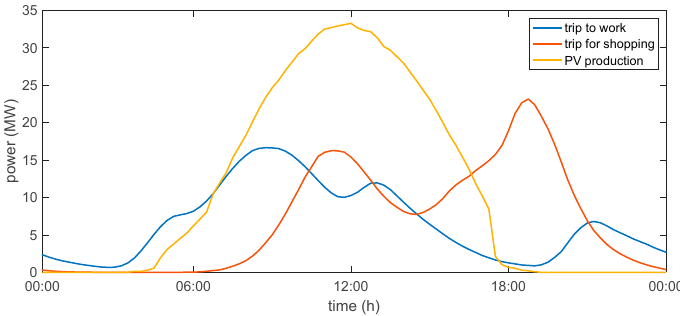
Figure 9. Generic example of a load profiles of the user groups “trip to work” and “trip for shopping” as well as a PV production profile.